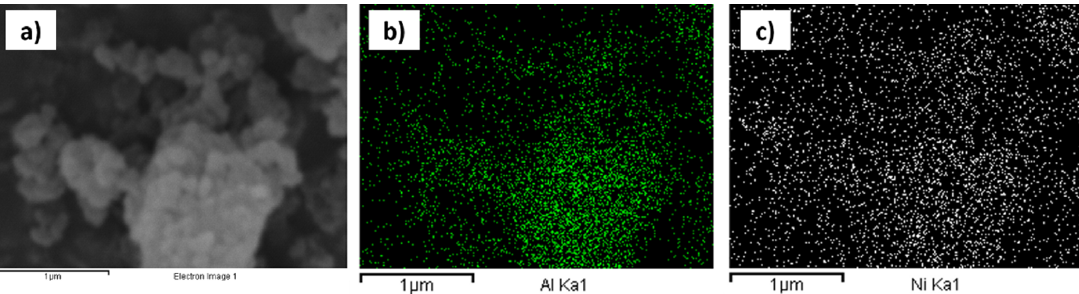
Figure 5. Energy-Dispersive X-ray images of AlNi1. ( a ) SEM image, ( b ) Al content, and ( c ) Ni content.